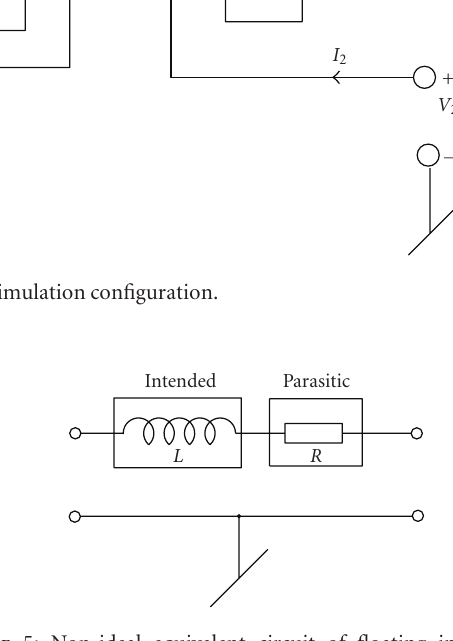
Figure 5: Non-ideal equivalent circuit of floating inductor of Figure